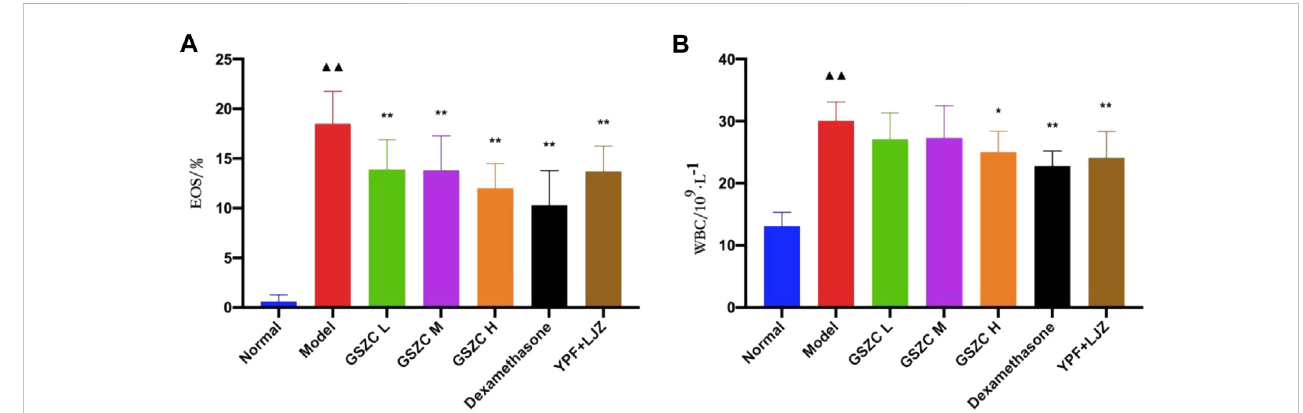
FIGURE 5 EffectsofGSZCgranulesonEOS (A) ,WBC (B) inBALFinratssufferingfromasthma.Valuesarethemean±SD,n=10foreachgroup. ▲▲ p < .01 versus the normal group, * p < .05, ** p < .01 versus the model